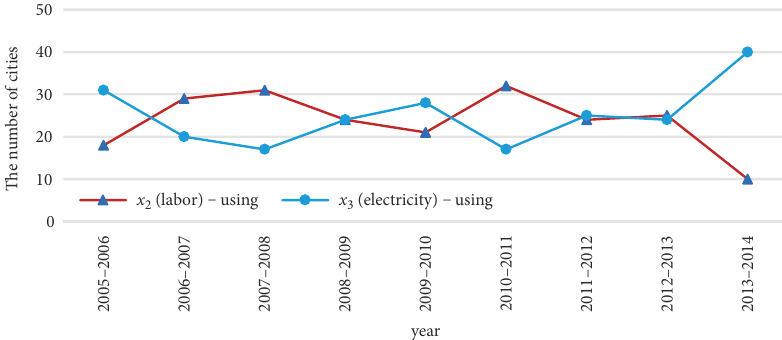
Figure 5. Input biased technological changes of labor ( x 2 ) and electricity consumption ( x 3 )